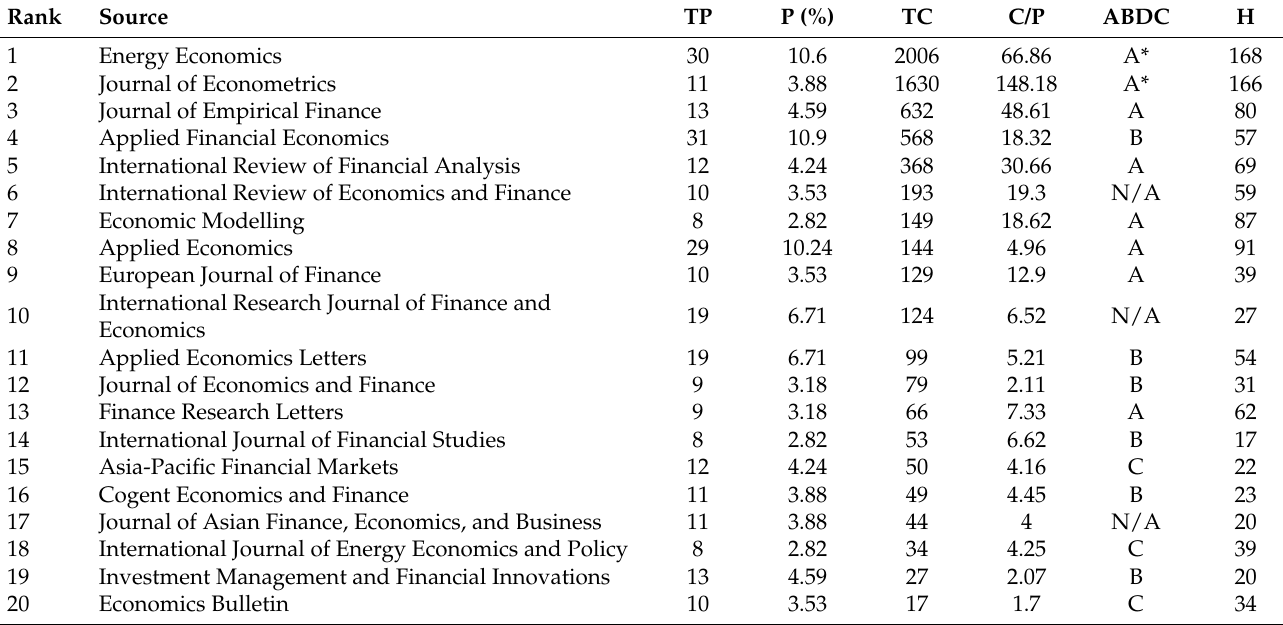
Table 3. Ranking of top 20 influential Journals.